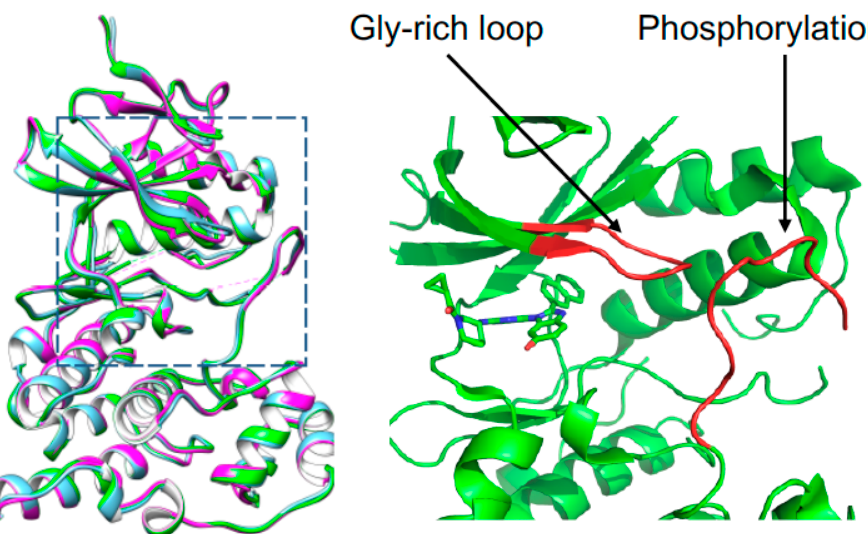
Figure 3. Overall structure of apo-(purple), fragment-bound (cyan), and inhibitor-bound (green) JNK3. The structural difference occurred at glycine-rich region and phosphorylation lip, which were enlarged on right and indicated. In the overlayed structures, the bound molecules were removed for the clarity of structural comparison.